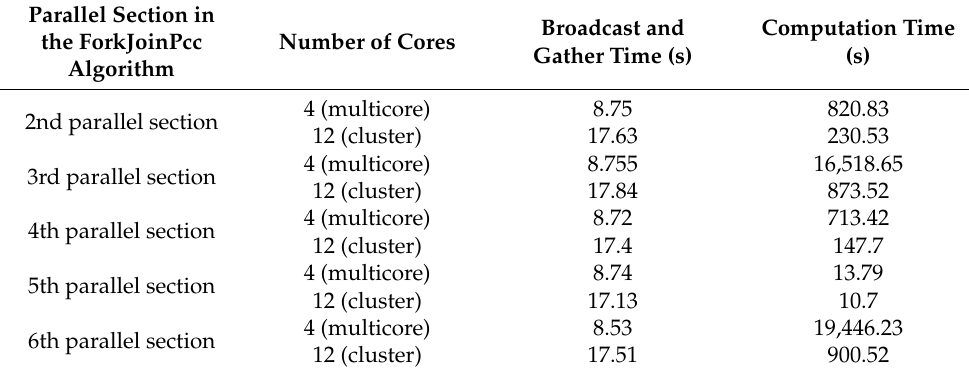
Table 3. Broadcast and gather and computation times for the second, third, fourth, fifth, and sixth parallel sections in the ForkJoinPcc